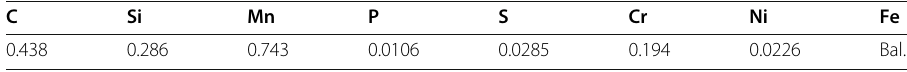
Table 4 Chemical composition of C45 steel after surfacing